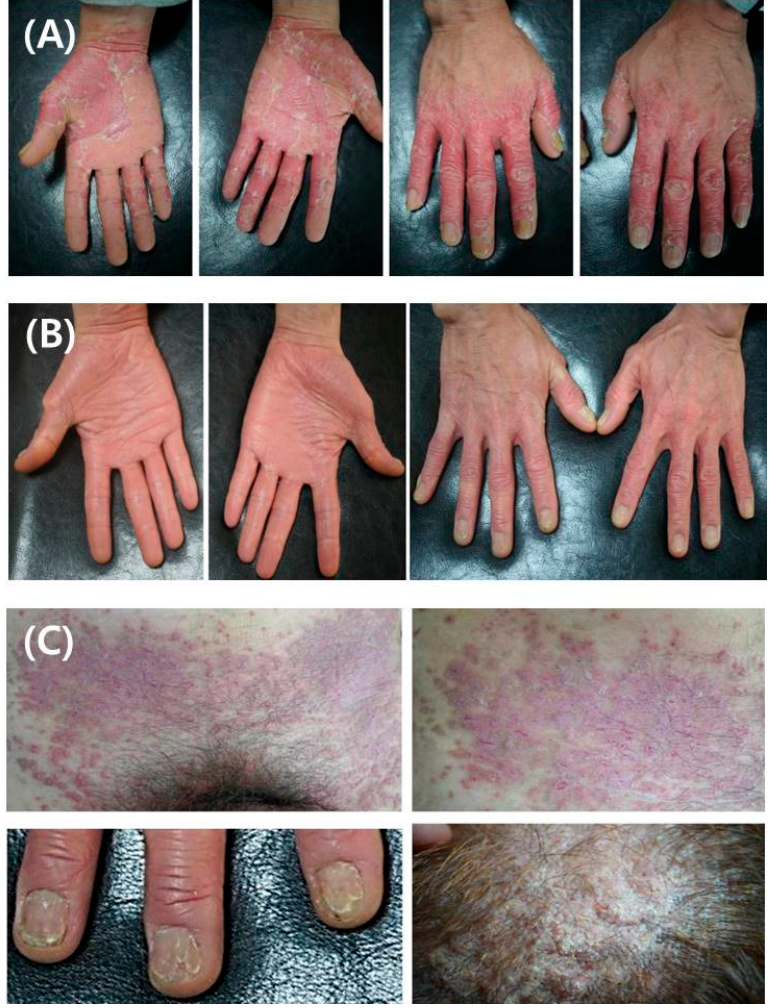
Figure 2. ( A ) Despite continuous treatment for psoriasis vulgaris, the skin lesions on the hands deteriorated. ( B ) After ixekizumab was administered to the patient for psoriasis, pruritus and skin lesions in both upper and lower extremities were significantly improved. ( C ) While continuing ixekizumab treatment for 18 months, the patient showed sudden worsening skin lesions on the scalp, abdomen, and finger nails (V-shaped nicks) with pruritus.